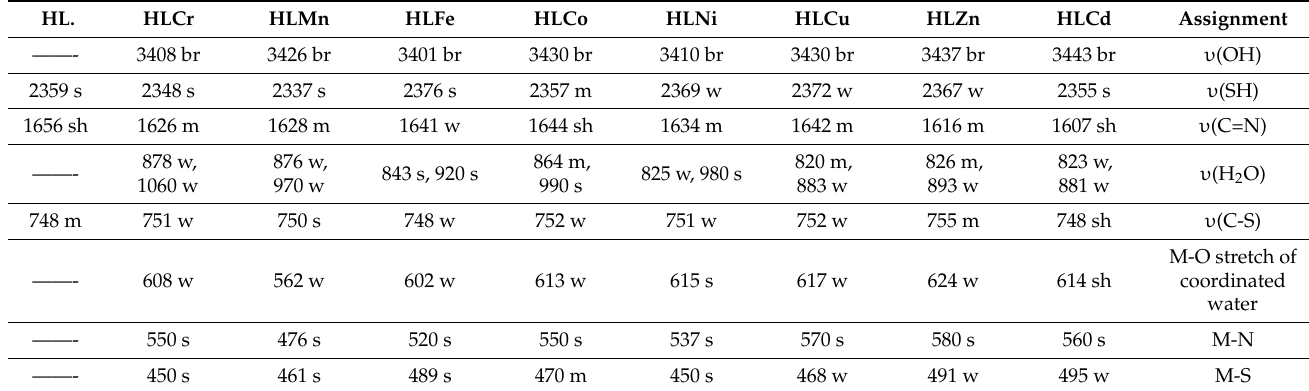
Table 2. IR spectra (4000–400 cm − 1 ) of HL ligand and its metal